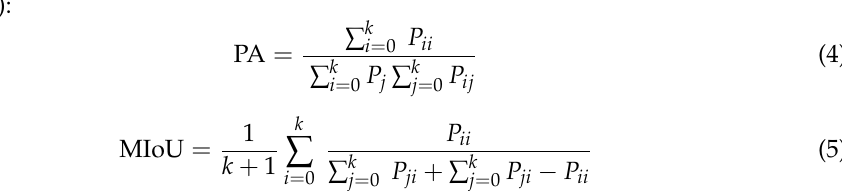
Figure 8. Loss and accuracy curve from character classification network training.